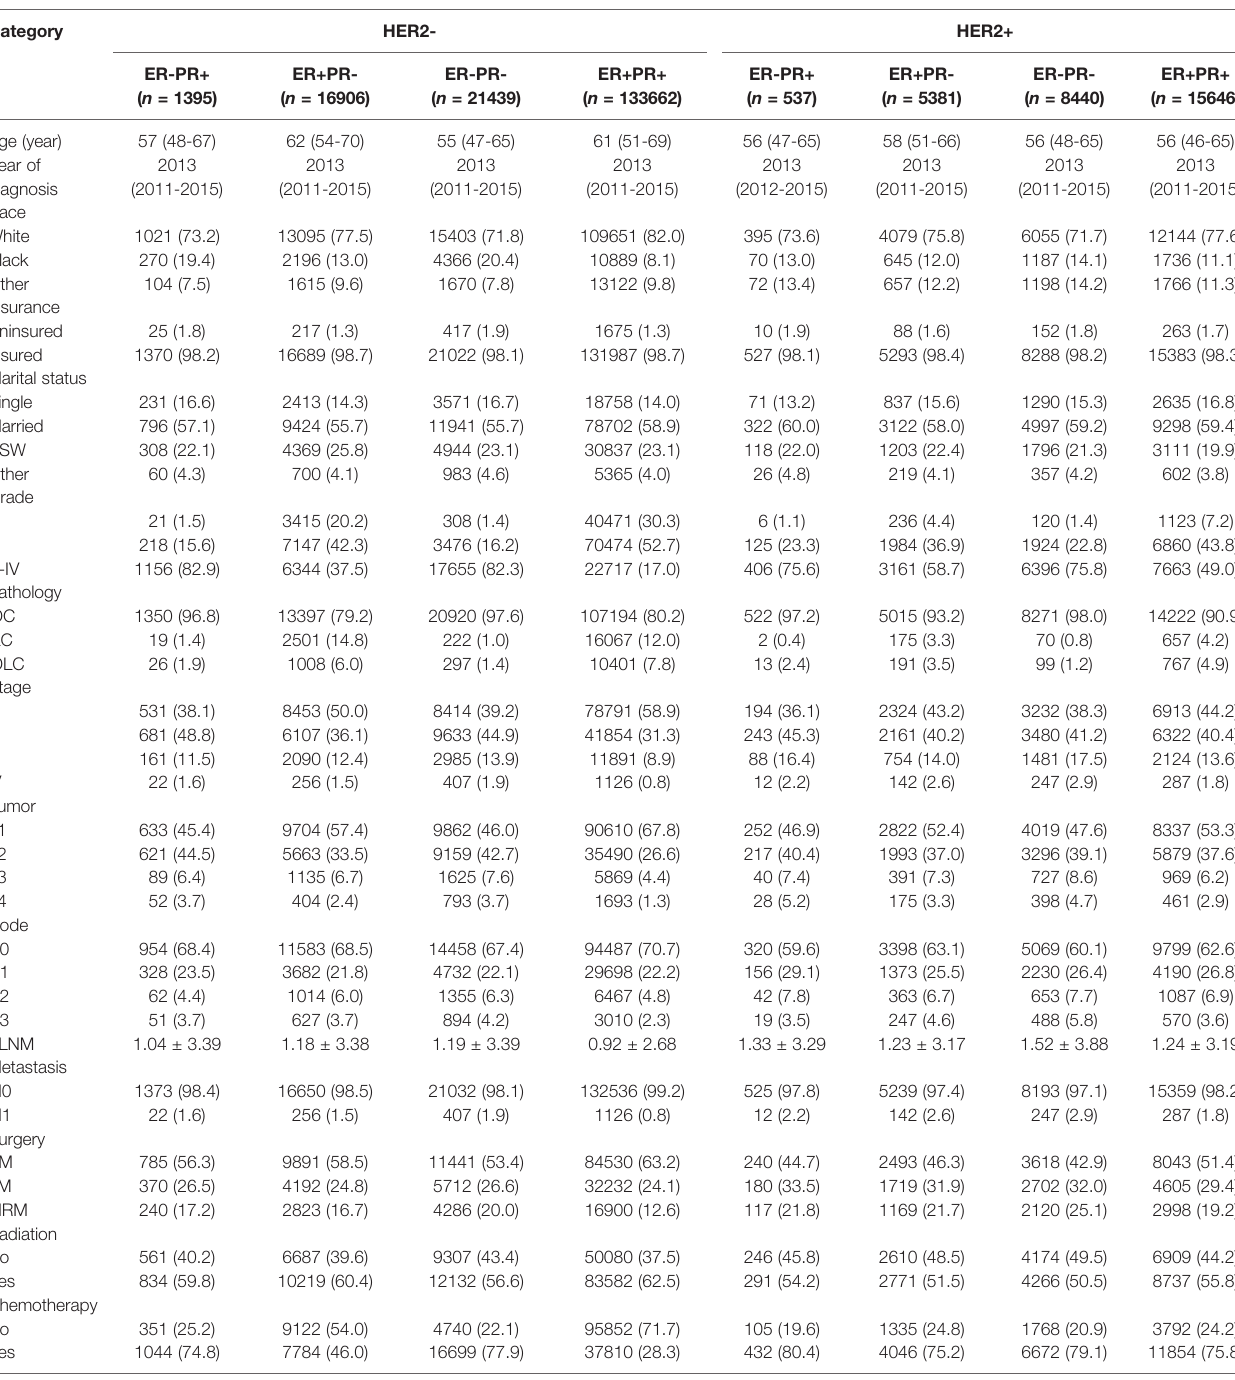
TABLE 1 | Clinicopathologic characteristics of the study population ( n = 203,406).